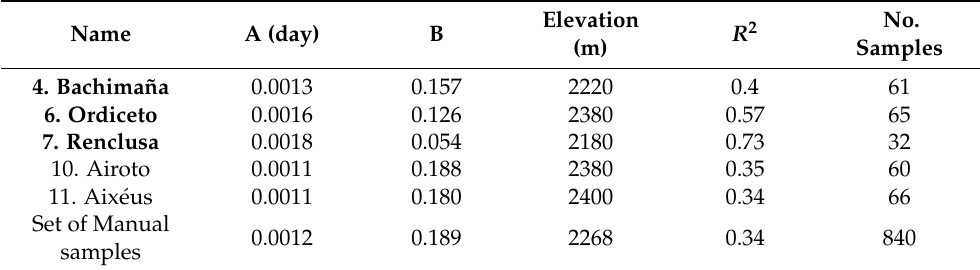
Table 7. SDEN intra-annual time dependence for manual sampling in the most representative TNM sites and the set of manual samples. Bold letters are used for manual samples in the same locations as selected TNM sites.